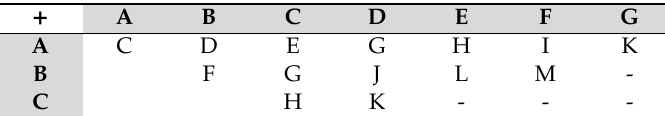
Table 2. Material transitions during agglomeration.